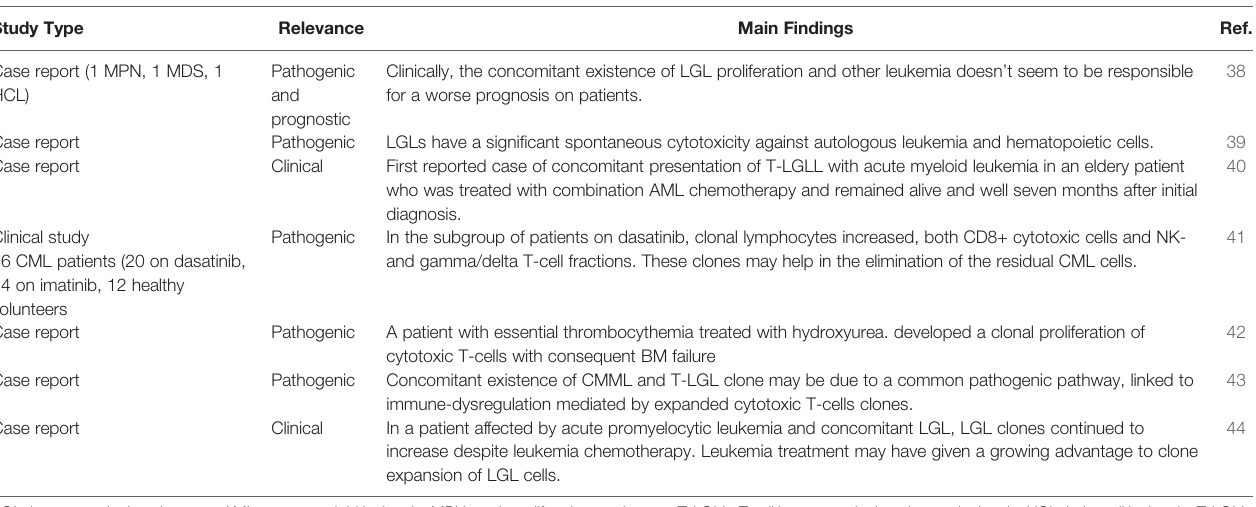
TABLE 2 | Large granular lymphocytes in acute myeloid leukemia and myeloproliferative